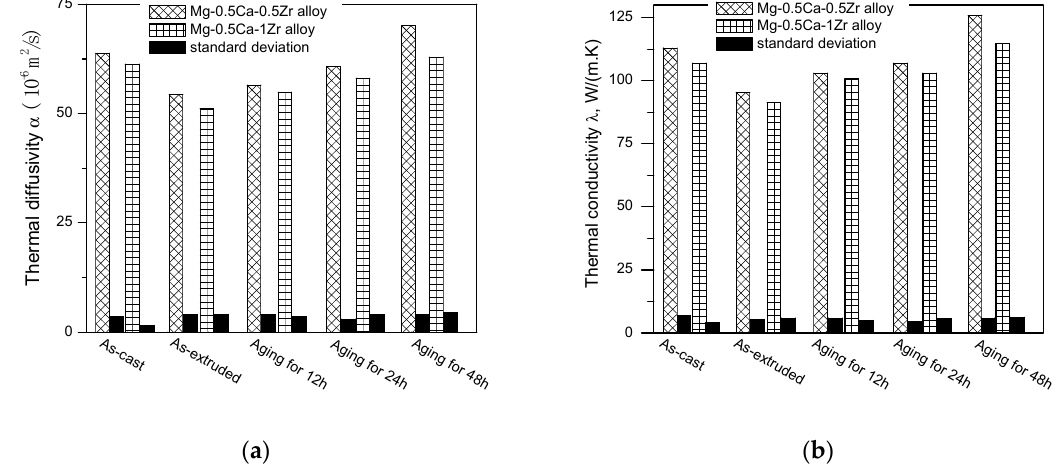
Figure 12. ( a ) Thermal diffusivity and ( b ) thermal conductivity of the Mg alloys. In general, the TC of the alloys consists of the electronic TC and lattice TC, since the phonons and electrons are the main carriers of heat in alloys [11,20,48]. When Mg forms an alloy with the other elements, a solid solution or metallic compound is usually formed, and the crystalline lattice of the α -Mg matrix is distorted. Solute atoms, metallic compounds and lattice defects are the scattering centers of electrons and phonons, which can prevent the free movement of electrons and thus deteriorate the thermal properties of the alloy [10,12,48]. Generally, metallic compounds, solute atoms, lattice defects (dislocation, vacancy, grain boundary) and temperature influence the TC of Mg alloys [21,48]. Among them, the TC of alloys is greatly influenced by metallic compounds and solute atoms [21]. TC, as the most important heat dissipation property of Mg alloys, is also sensitive to the microstructure of Mg